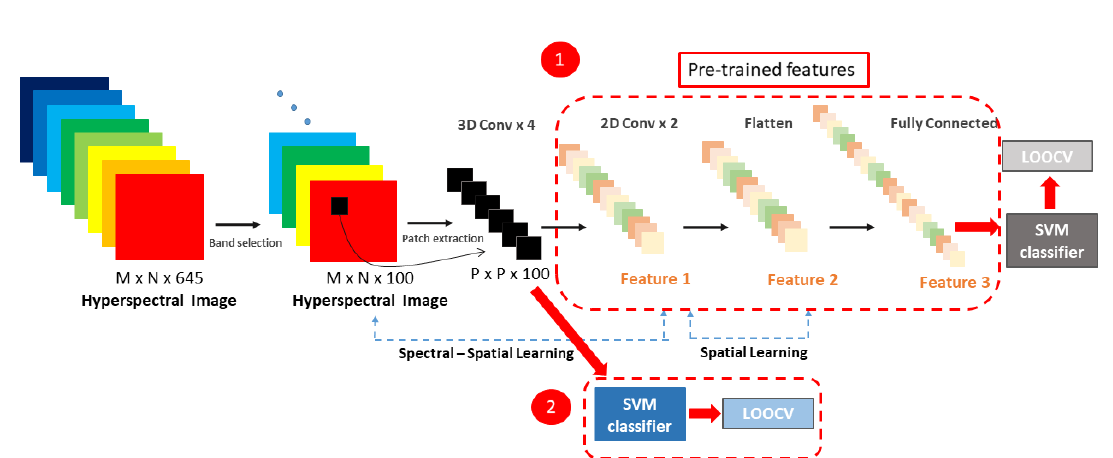
Figure 3. A 3D–2D hybrid CNN architecture for feature extraction and classification adapted from Roy et al. [30]. At the left the band selection and patch extraction is shown. In the middle, (1) feature extraction is shown by using 3D and 2D CNN for giving the final classification output based on an SVM classifier. (2) The intensity values of the patch extracted are used to feed an SVM classifier and perform a supervised